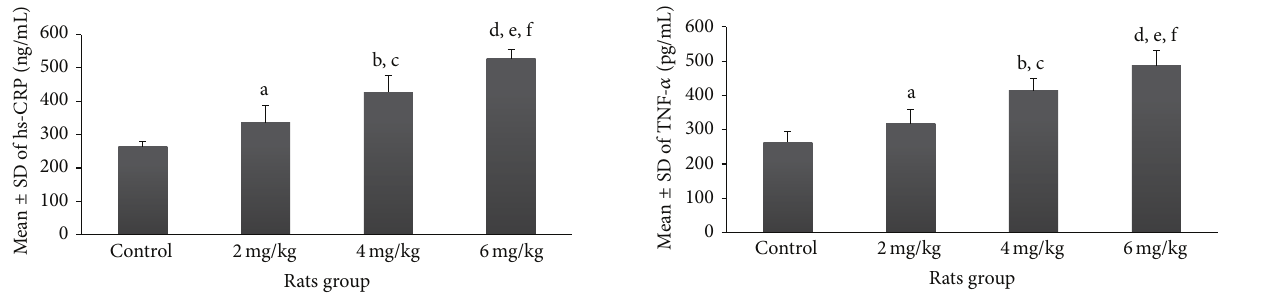
Figure 1: Prenatal exposure to nicotine in pregnant rats increased theinflammatorymarkerhs-CRPinnewbornrats.Mean ± SDofthe hs-CRP marker is shown in different groups of newborns. 𝑁 = 8 (a: 𝑃 < 0.05 in 2 mg/kg group versus control group; b and c: 𝑃 < 0.001 in 4mg/kg group versus control group and 2 mg/kg group, resp.; d, e, and f: 𝑃 < 0.0001 , 𝑃 < 0.0001 , and 𝑃 < 0.001 in 6mg/kg group versus control, 2 mg/kg, and 4 mg/kg groups, resp.).